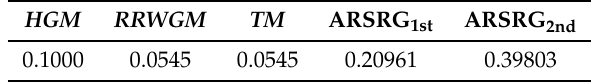
Table 5. Quantitative comparison, using the MRR measure, among the HGM [15], RRWGM [33], and TM [34] algorithms and the ARSRG matching on the dataset in [28].